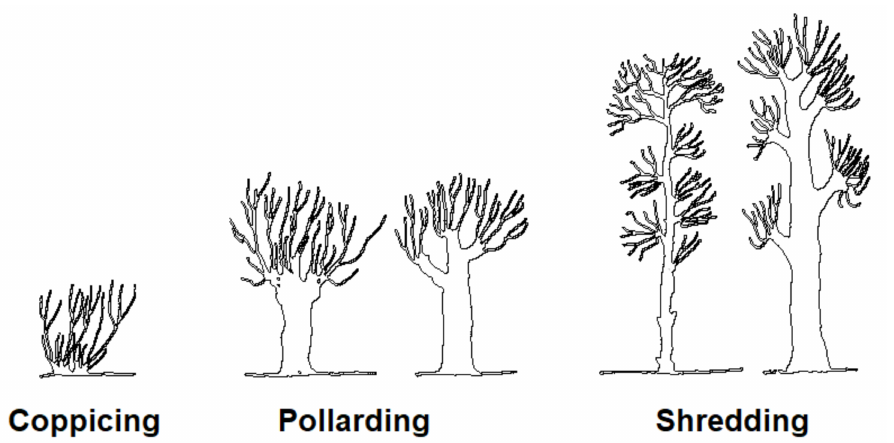
Figure 1. Woodland management systems. Based on a drawing prepared by